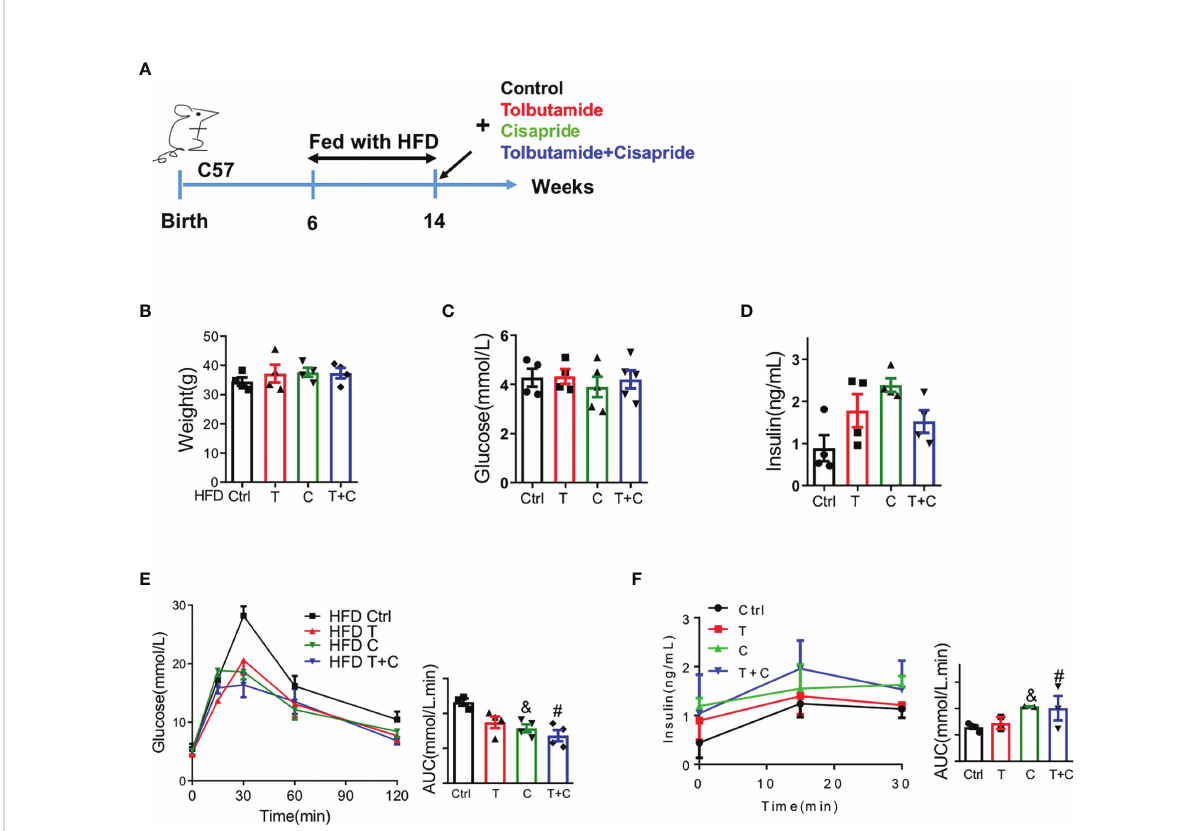
FIGURE 2 Cisapride regulated glucose metabolism in wild-type mice fed a high-fat diet (A) Wild-type (WT) mice were fed a high-fat diet (HFD) for 8 weeks before the experiment. (B) Body weight, (C) fasting blood glucose and (D) fasting serum insulin were measured. (E) Different drugs were administered transiently to WT mice, including the control (physiological saline, Ctrl), tolbutamide (T, 20 mg/kg), cisapride (C, 10 mg/kg) and tolbutamide combined with cisapride (T+C). Intraperitoneal glucose tolerance tests (IPGTTs) were performed in the 4 groups. (F) Intraperitoneal insulin release tests (IPIRT) were performed. n=5 for each group (B – F) & P < 0.05, # P < 0.05 vs. Ctrl. Statistical comparisons were calculated using the Mann – Whitney U test (A – E)